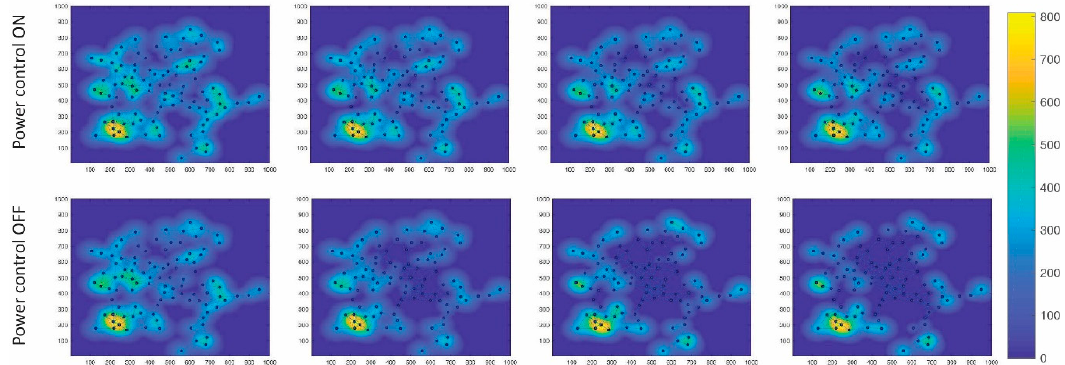
Figure 5. Clustered network power level heatmap demonstrating the changes in the nodes power level in four stages of the running network.